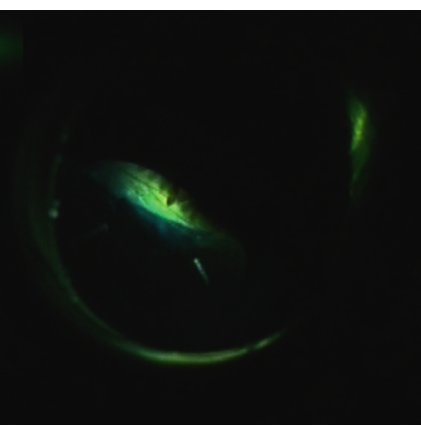
Figure 1: The ciliary processes are clearly visible in the visual field of the operation microscope when performing